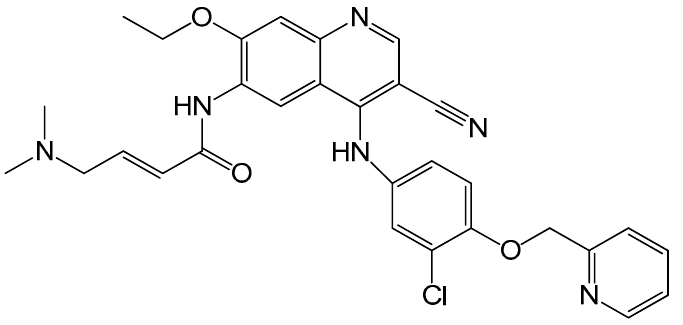
Figure 8. Chemical structure of neratinib, with the chemical formula C 30 H 29 ClFN 6 O 3 S and a molecular weight of 557.0427 g/mol.